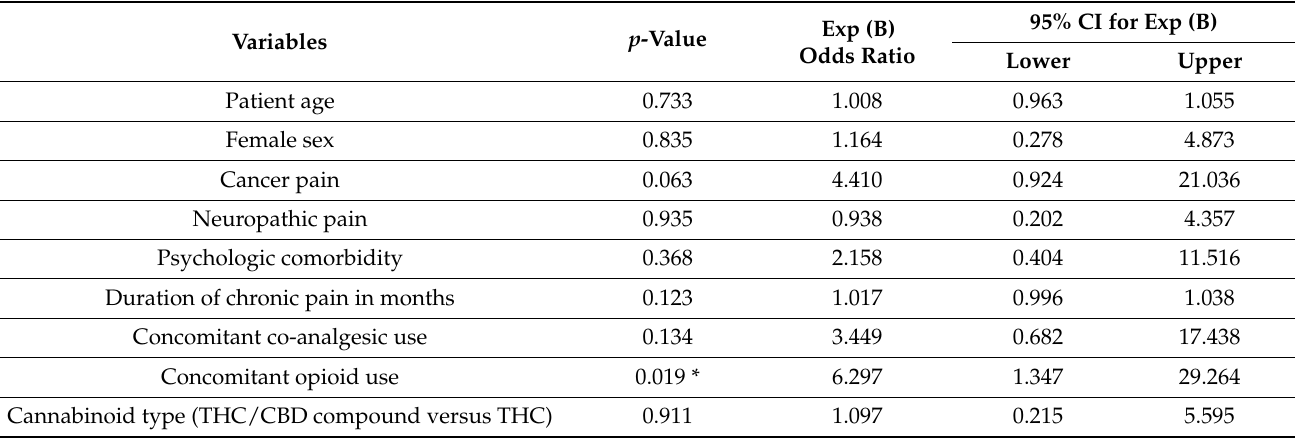
Table 6. Multivariate regression analysis of the association between at least a 30% improvement in tolerability and different variables with cannabinoid